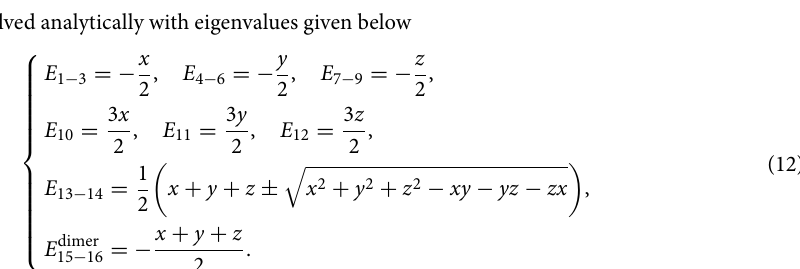
Figure 2. Phase diagram for the fully anisotropic XYZ model in Eq. (9). We have assumed x sin (θ) . The phase boundaries between exact dimer phase and FM phases are determined by Eq. (13), while y = the dots are boundaries determined by order parameters, with absolute difference boundary given by Eq. (13)) less than 3.0 explained by mixing of two anisotropic dimer models; see Eq. (17). The classical limits are denoted as H (1, 0, 0), H (0, 1, 0) and H (0, 0, 1) and the dashed lines are conditions for exact FM